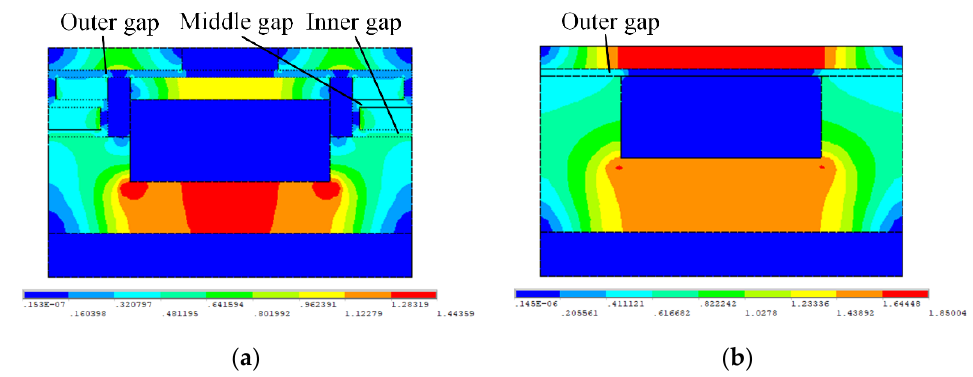
Figure 7. Contours of the magnetic flux density of the both MR damper: ( a ) Proposed MR damper; ( b ) Traditional MR damper.